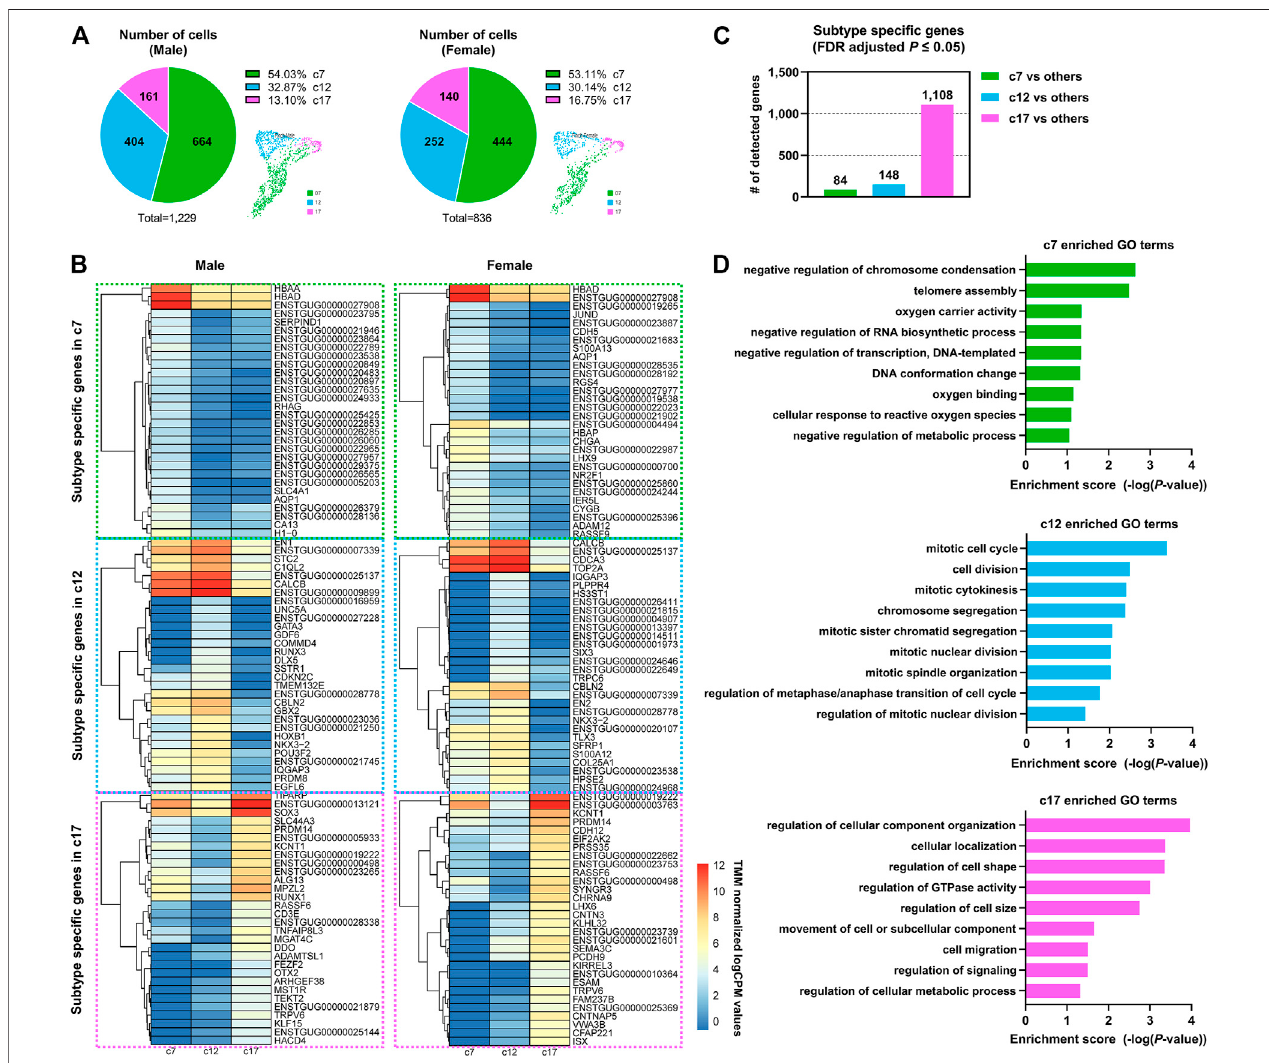
FIGURE 2 | Dynamic gene expression patterns in PGC subpopulations at a single developmental stage. (A) The number and portion of PGCs allocated to each subpopulationinbothsexes. (B) Heatmapofdifferentiallyexpressedgenes(DEGs)betweenthreedistinctPGCclustersinbothsexes. (C) NumberofDEGsinonecluster compared to all other clusters. (D) Representative Gene Ontology (GO) terms for PGC subpopulation-speci fi c genes.